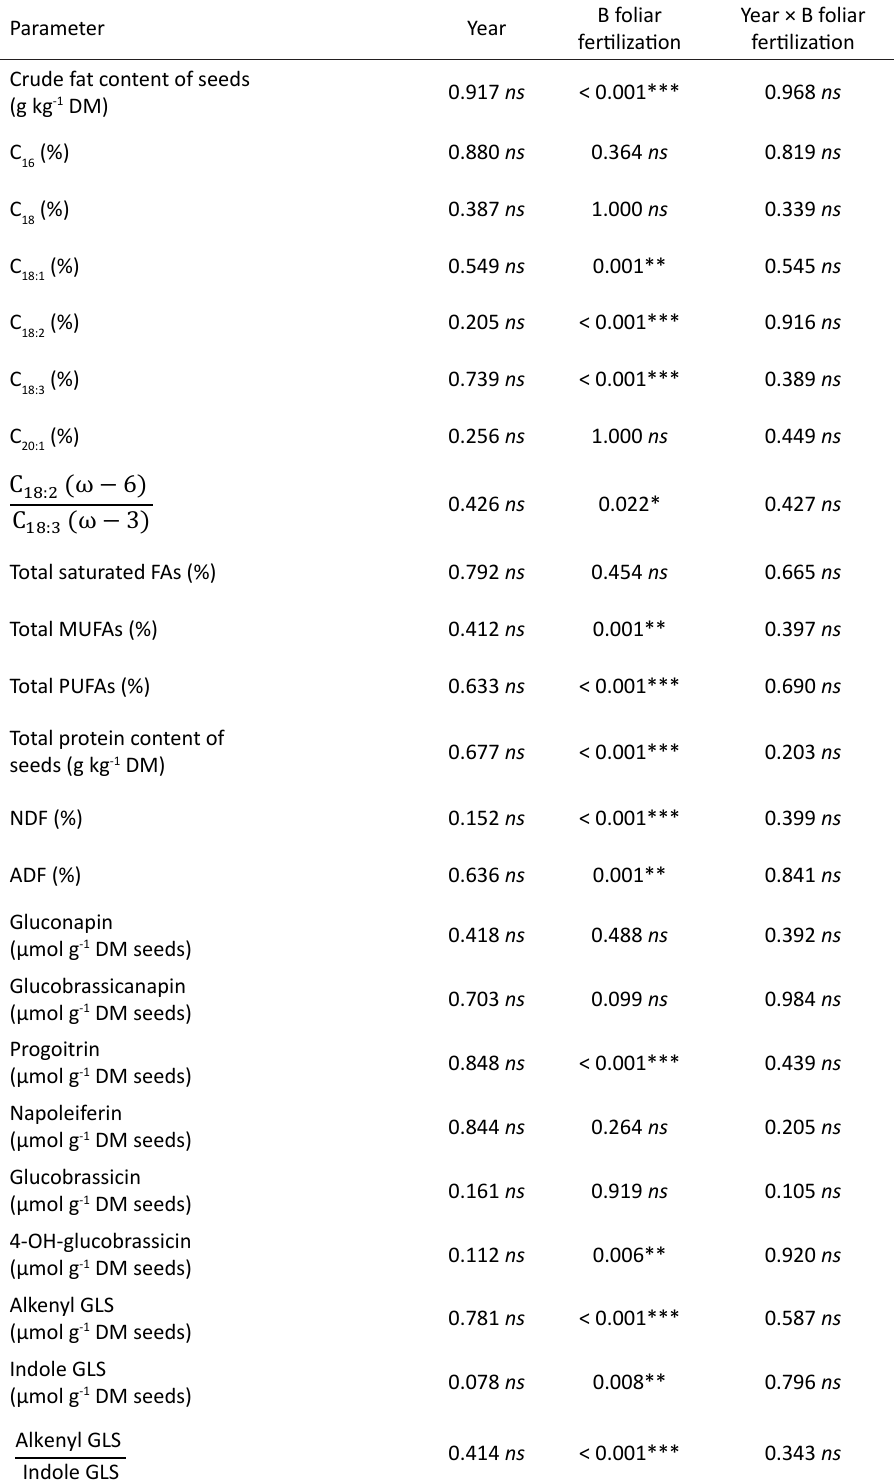
Table 4. P values ( p > F) in fixed effects tests for nutritional value and feed value of winter oilseed rape